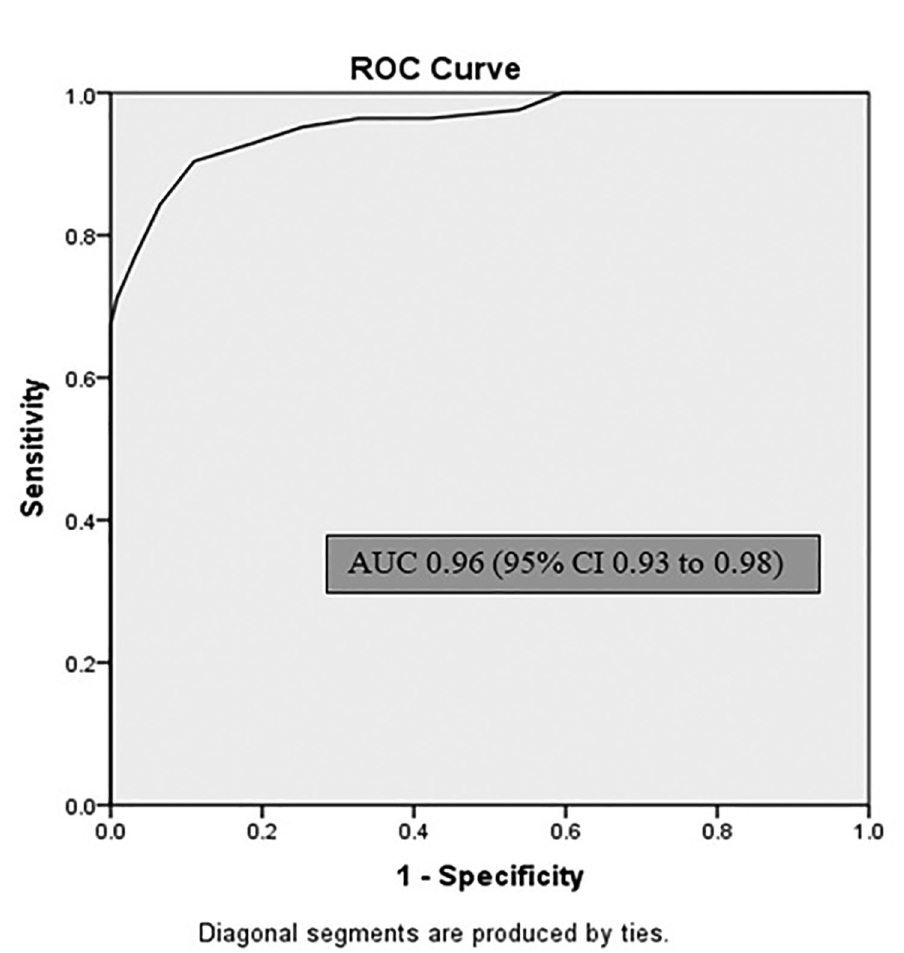
Figure 3. Receiver operating characteristic (ROC) curve for sublingual infrared temperature recordings. AUC = area under curve; CI = confidence